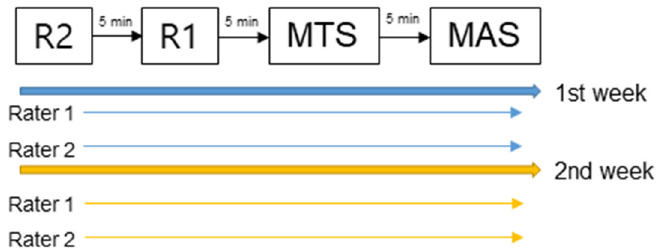
Figure 1. Flow diagram of the procedure.